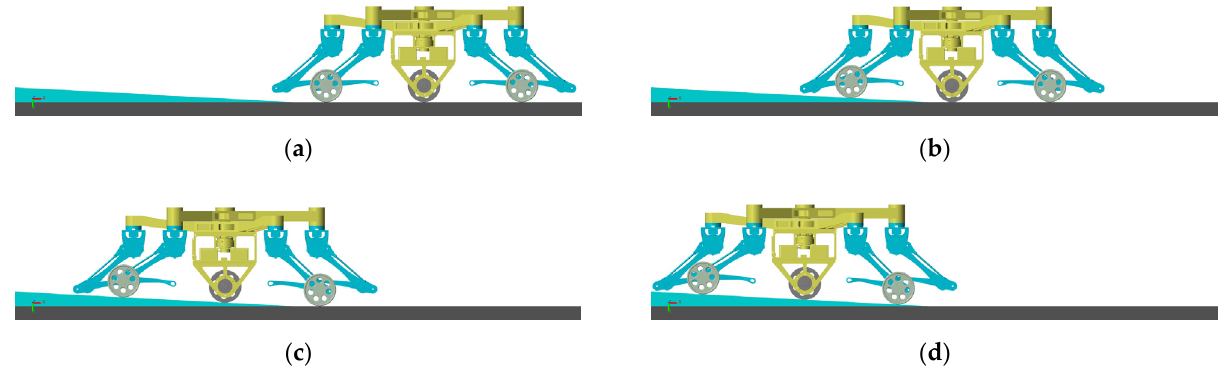
Figure 14. Simulation of wheeled motion (all wheels on slope). ( a ) no wheel on slope; ( b ) front wheels on slope; ( c ) front wheels and active wheel on slope; ( d ) all wheels on slope.